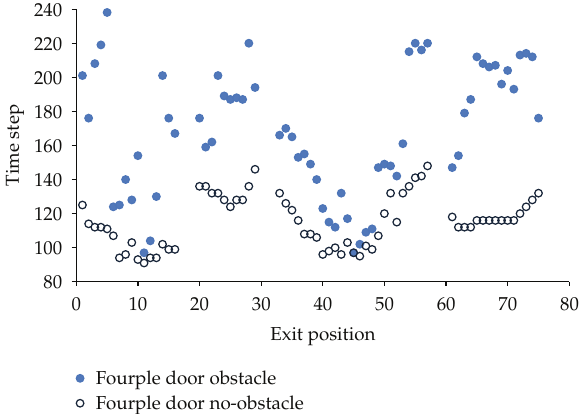
Figure 18: Evacuation time (cid:2) in time steps (cid:3) for di ff erent locations of one quadruple-door exit in the restaurant shown in Figure 12, with (cid:2) filled circles (cid:3) and without (cid:2) open circles (cid:3) obstacles.